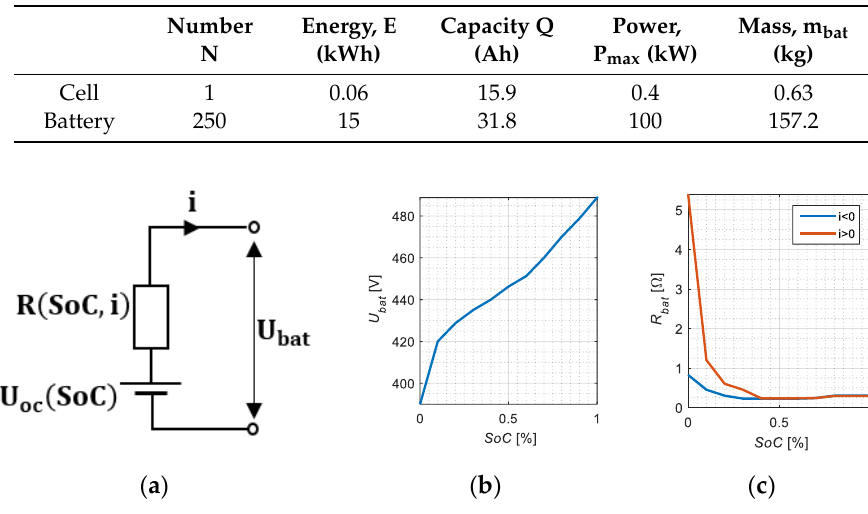
Figure 6. Battery equivalent circuit ( a ), battery voltage vs. state-of-charge (SoC) dependence ( b ), internal resistance vs. SoC and current direction ( c ).